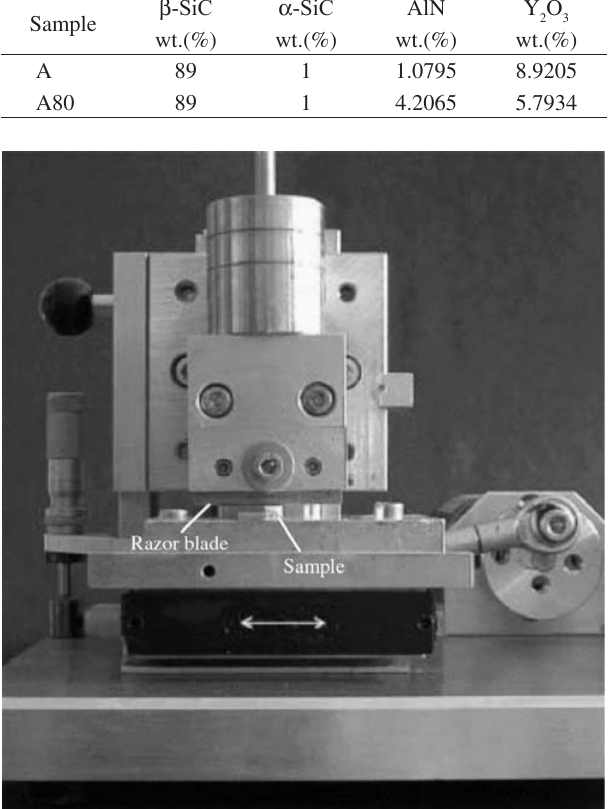
Figure 1. Crack formation by Vickers indentation. Figure 2. Equipment used to produce a sharp V-notch with a razor